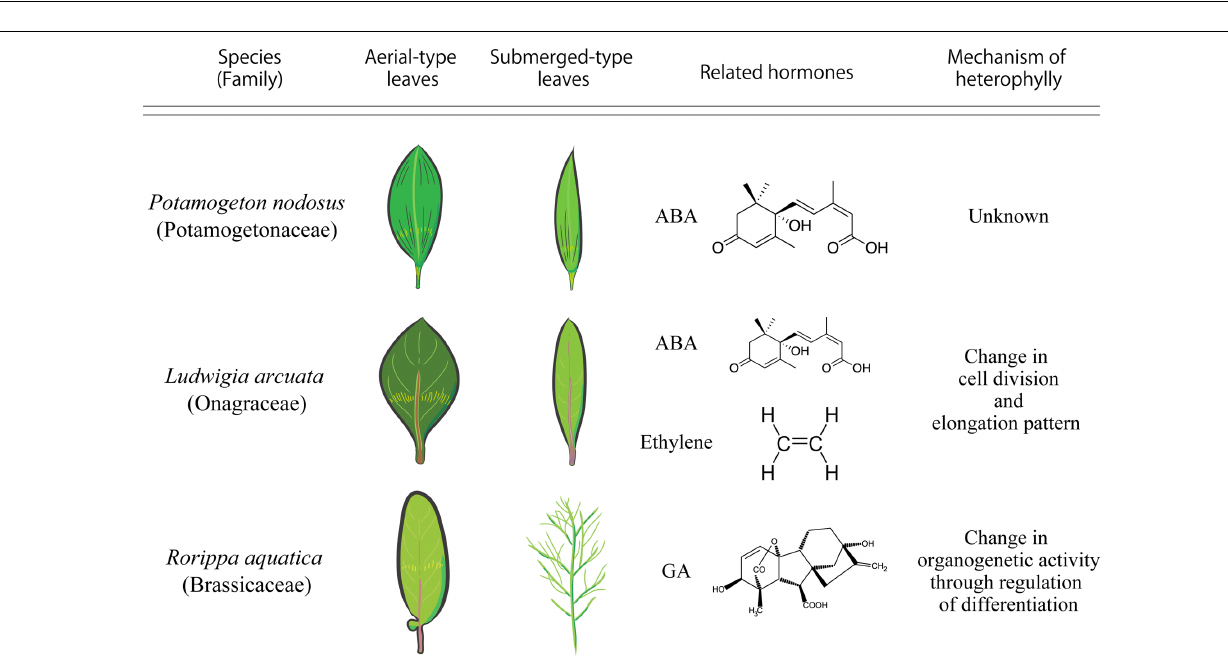
FIGURE 2 | Comparison of heterophylly seen in Potamogeton nodosus , Ludwigia arcuata , and Rorippa aquatica